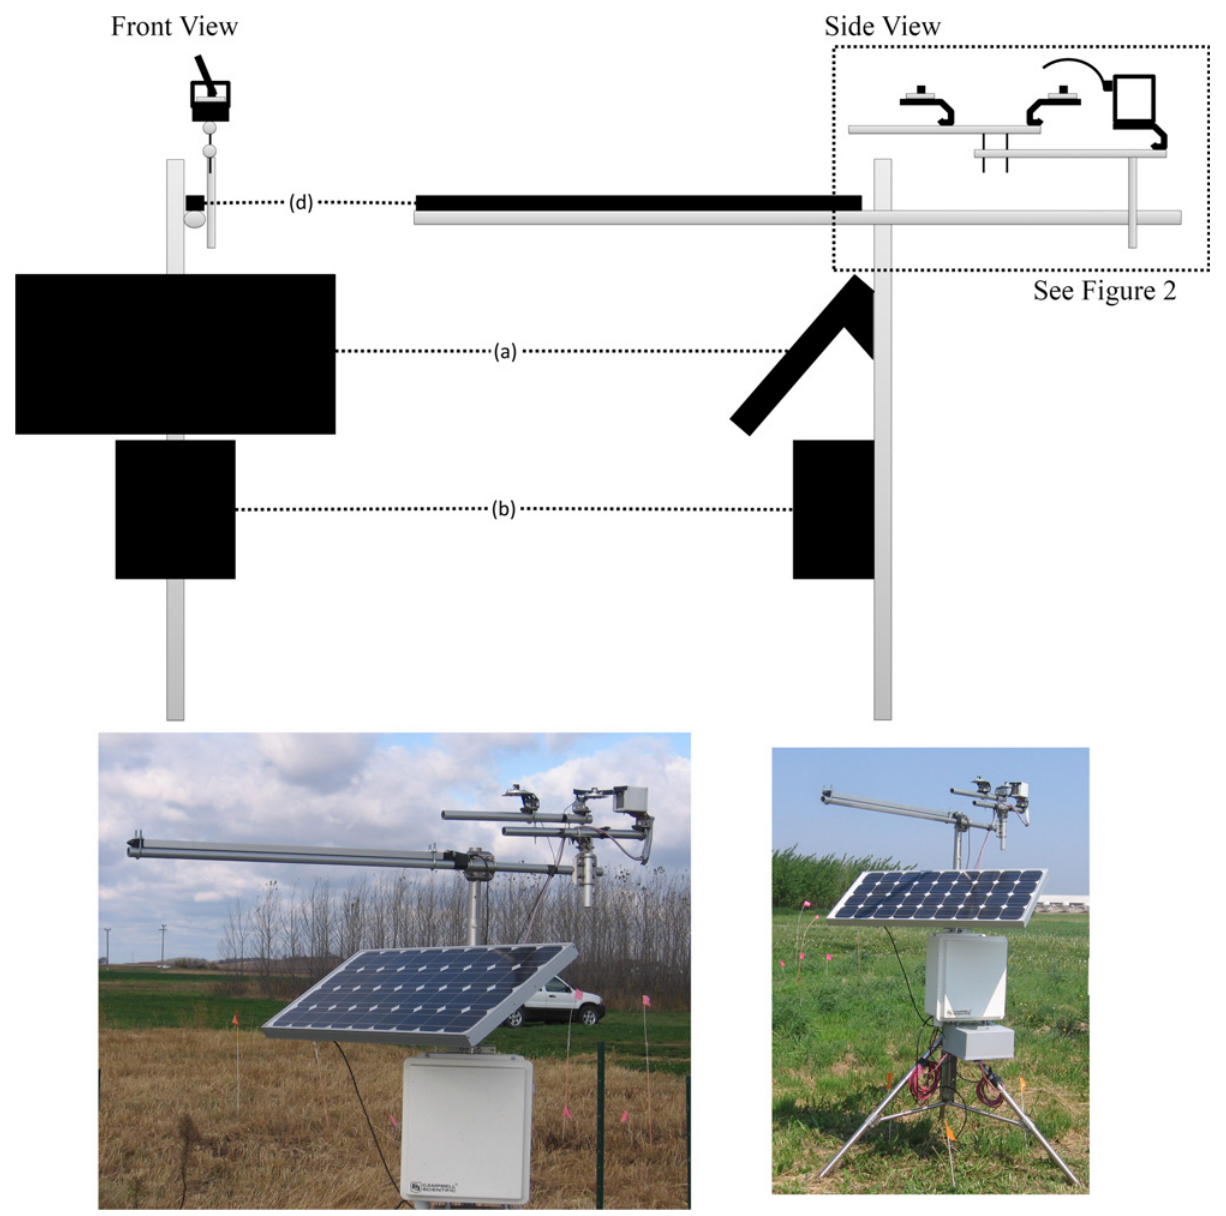
Figure 2. Large scale view of shadowband apparatus design (not to scale). Components listed in Table